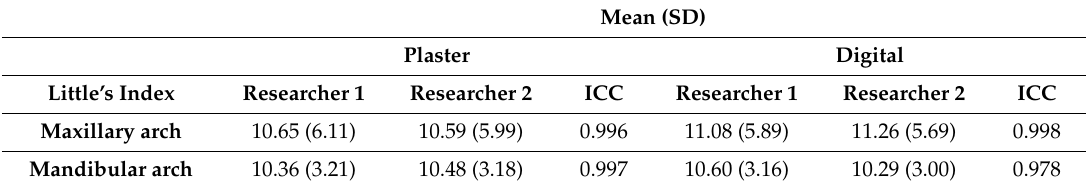
Table 2. Inter-operator reliability for the plaster and digital measurements. Units are represented in millimeters. ICC = intraclass correlation coe ffi cient.